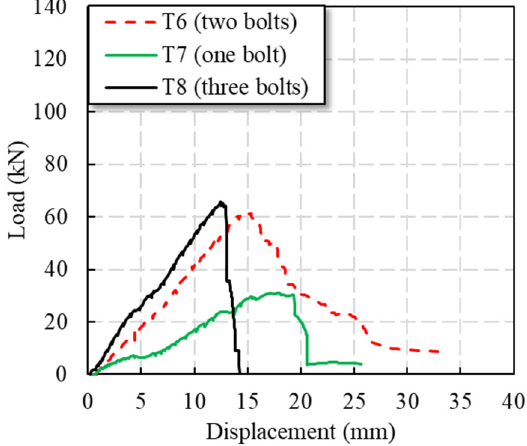
Figure 6. Load–displacement curves of specimens with different numbers of bolts .